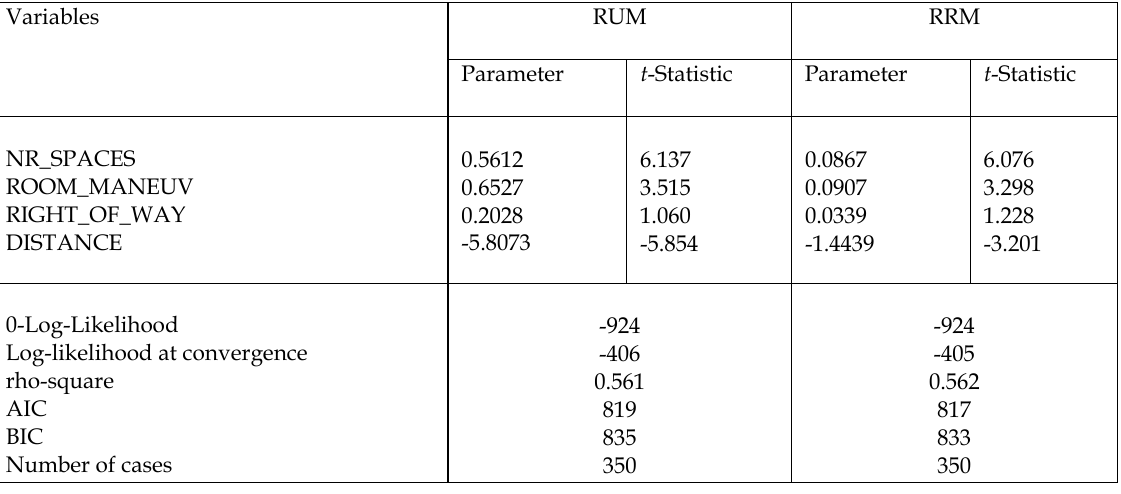
Table 3. Parking lot choices (estimation results)